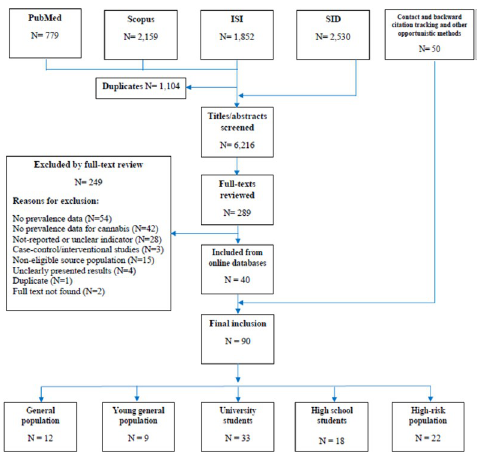
Fig 1. Flow diagram of study